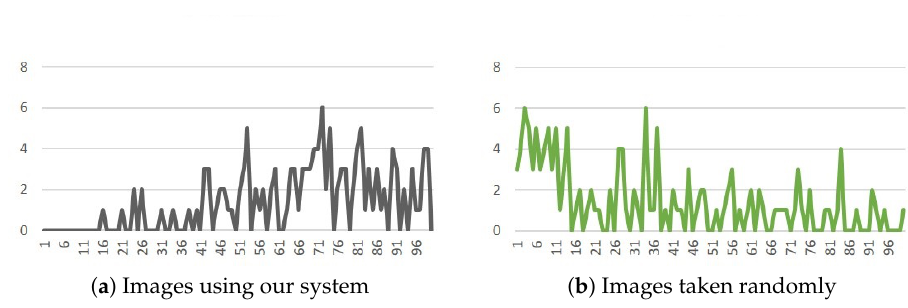
Figure 45. Results for the frame-within-a-frame composition